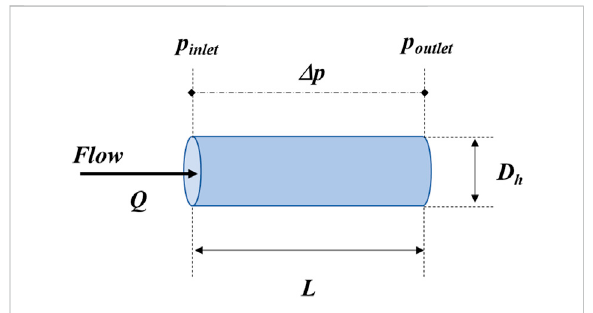
FIGURE 1 Representation of the geometric and fl ow parameters of the microchannel corresponding to Eq.